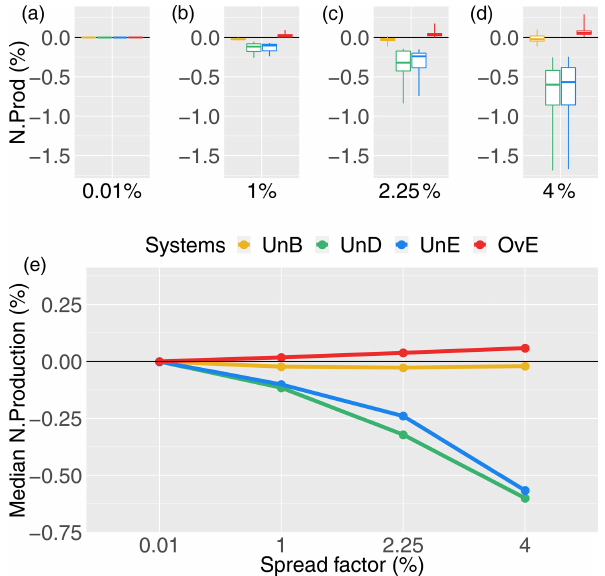
Figure 10. Total hours of production of the synthetic ensemble fore- casting systems as a percentage of the total hours of production of the reference system (i.e., the “perfect system”, where forecasts are equal to observations): unbiased system (UnB, yellow), underdis- persed system (UnD, green), underestimating system (UnE, blue) and overestimating system (OvE, red). Systems are based on en- sembles generated with four different spread factors (0.01%, 1%, 2.25% and 4%). (a–d) Boxplots represent the maximum value, per- centiles 75, 50 and 25, and minimum value over the 10 studied catchments. (e) Median